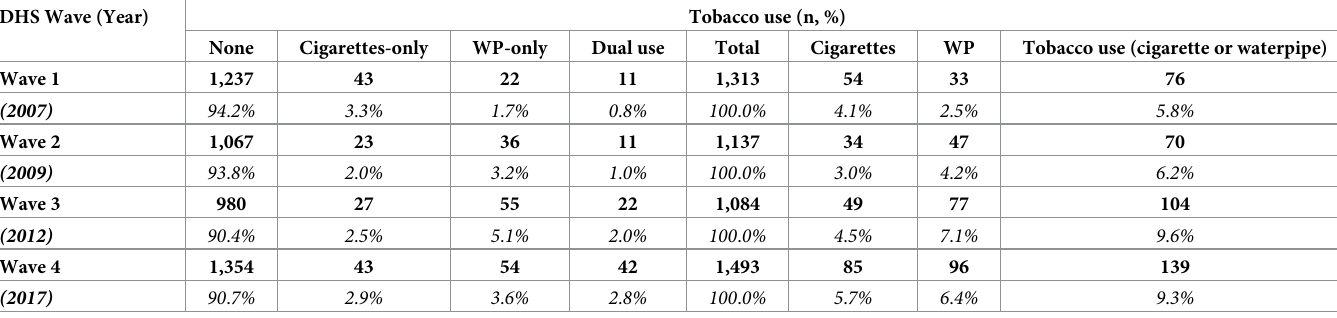
Table 3. Prevalence of tobacco use among pregnant women across the four waves of Jordan DHS data. DHS Wave